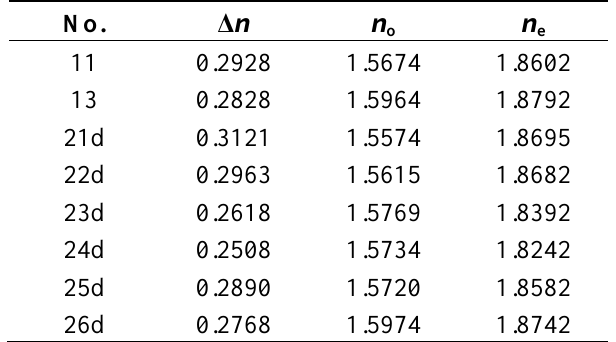
Table 5. Birefringence and refractive indices of alkyl and alkoxy isothiocyantotolanes at reduced temperature T = −10 N–I